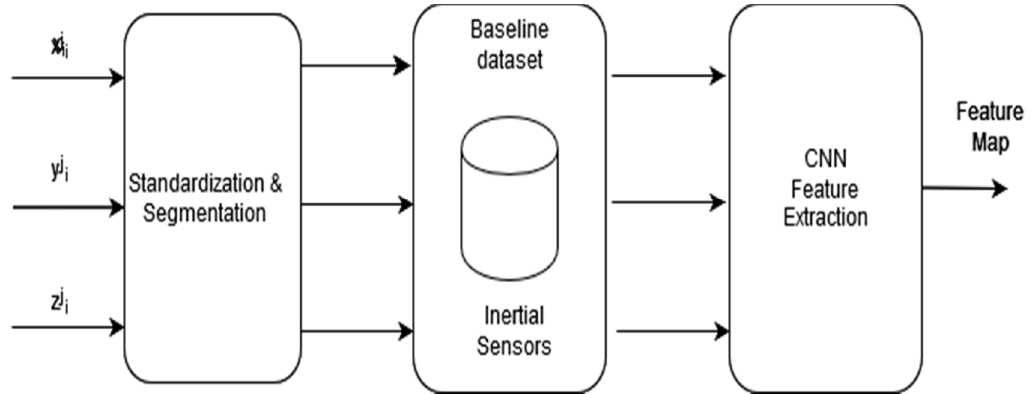
Figure 3. The baseline model with inertial sensing data.